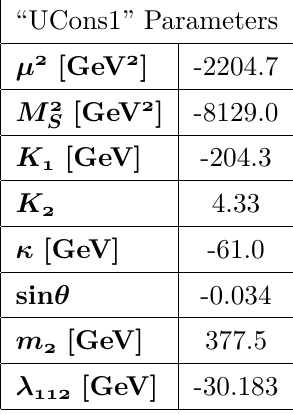
Table 1 . The real singlet-extended SM potential parameters, the sine of the mixing angle, mass m 2 and the tree-level triple coupling λ , for the benchmark point “UCons1” as it appears in table 2 112 of ref. [54], used as an example for fitting